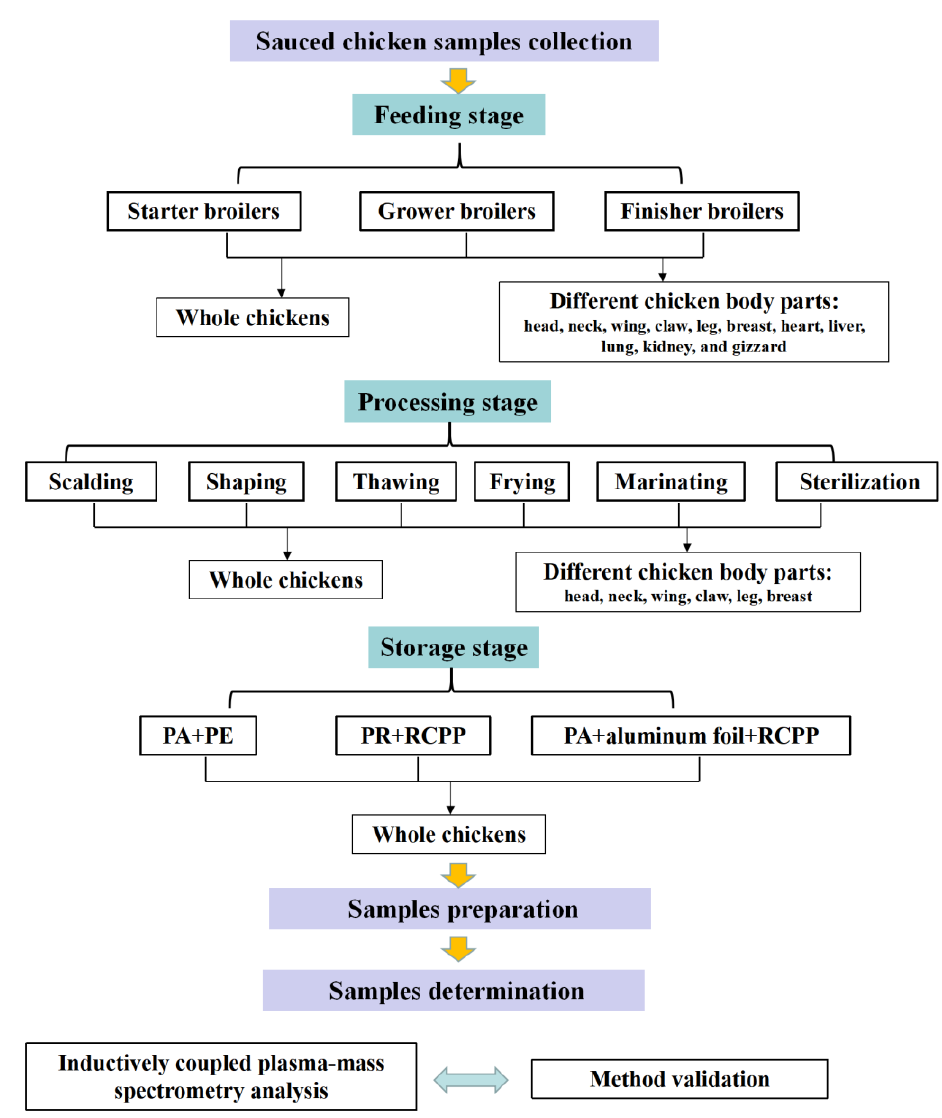
Figure 1. Skeletal scheme of the research methods.